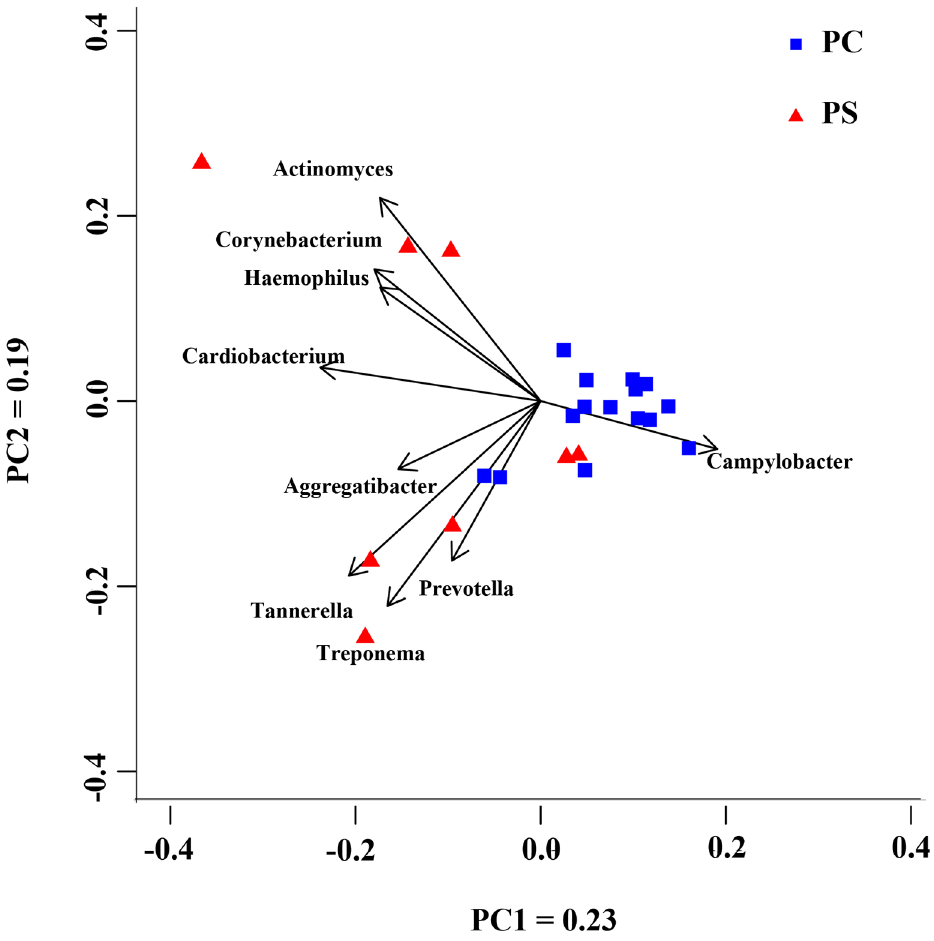
Fig 6. Principal component analysis of the bacterial genera detected in the dental plaque of the control group (PC) and black stain group (PS). The PC samples clustered together, with two samples mixed into the PS cluster, while the PS samples were more dispersive and seemed to cluster into two subgroups.